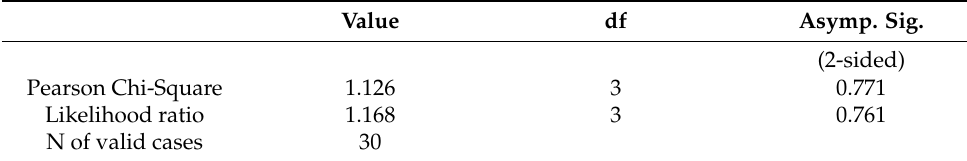
Table 10. Chi-square